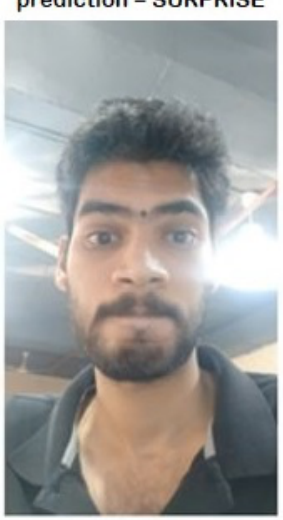
Figure 9. LARNet test results on real-time